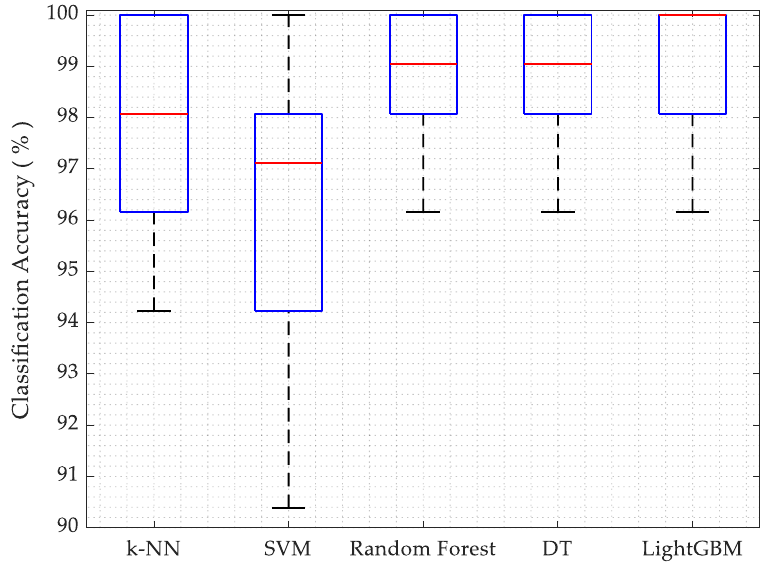
Figure 10. Classification accuracy for machine learning algorithms.